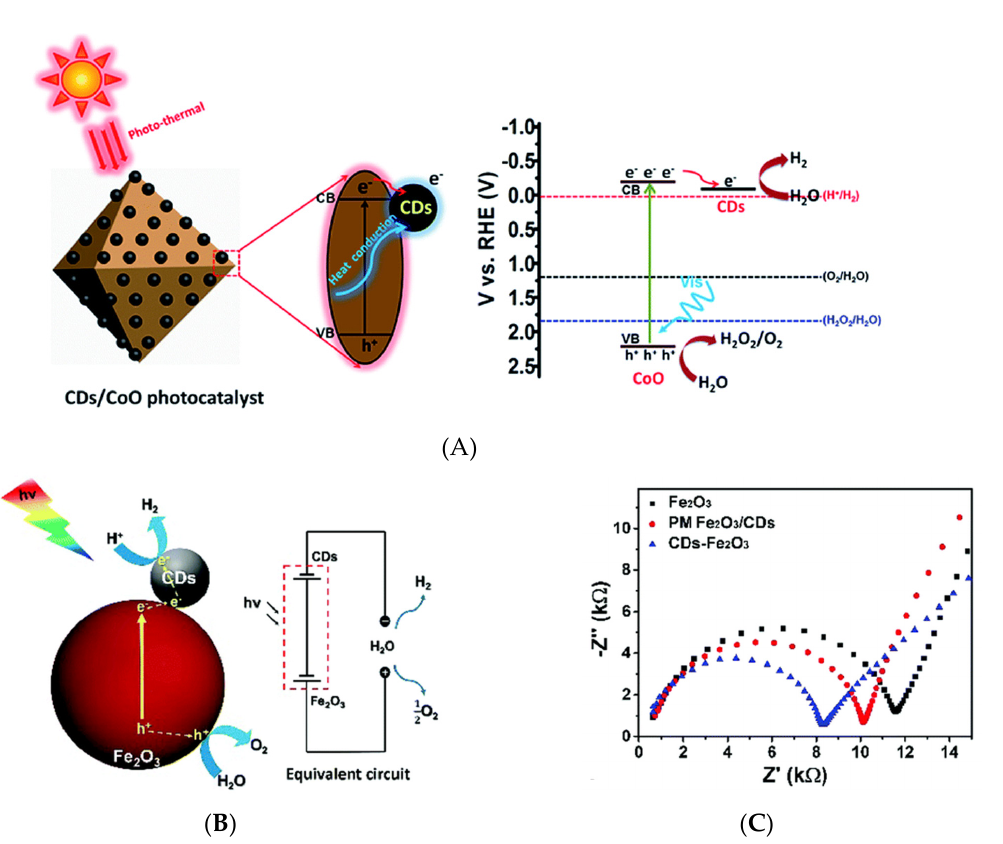
Figure 8. ( A ) The mechanism of visible-light driven water splitting by carbon dots decorated on octahedral CoO surface- Reproduced with permission from [67]—published by The Royal Society of Chemistry, 2017. ( B ) Water splitting mechanism of CDs / Fe 2 O 3 under visible light and the equivalent circuit, and ( C ) Electrochemical impedance spectra of Fe 2 O 3 , physically mixed CDs and Fe 2 O 3 (PM Fe 2 O 3 / CDs), and CDs / Fe 2 O 3 —Reproduced with permission from [68] published by The Royal Society of Chemistry, 2018.